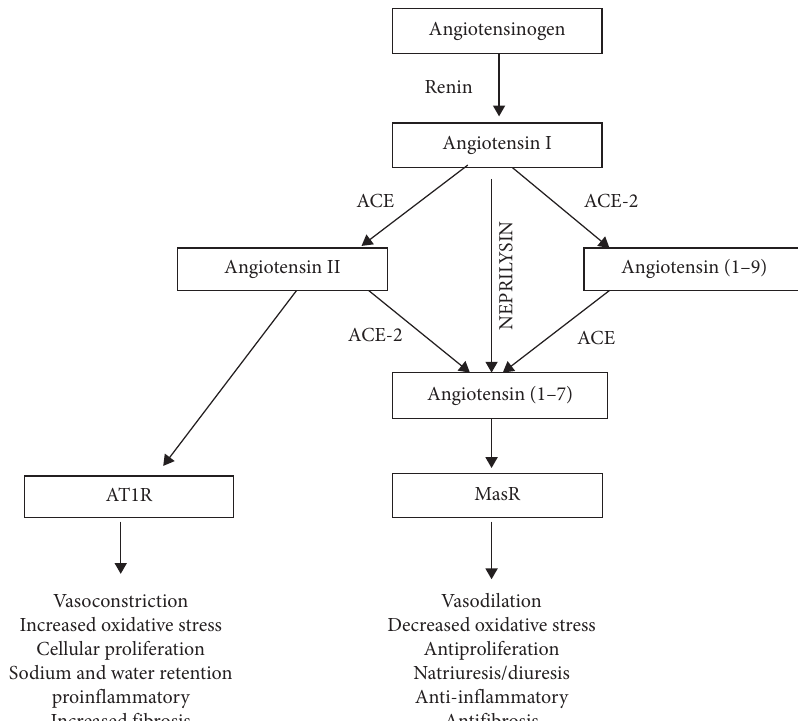
Figure 1: Roles of ACE (angiotensin-converting enzyme) and ACE-2 (angiotensin-converting enzyme-2) in the renin-angiotensin system. Renin cleaves angiotensinogen produced by the liver to angiotensin I which is further cleaved to angiotensin II by ACE enzyme. The primary function of the ACE-2 enzyme is to cleave angiotensin II to angiotensin (1–7) and angiotensin I to inactive angiotensin (1–9). The angiotensin II exerts its negative effects of vasoconstriction, proinflammation, and profibrosis through its interaction with the AT1R (angiotensin II type 1 receptor). In contrast, the angiotensin (1–7) exerts its beneficial effects of vasodilation, anti-inflammation, and antifibrosis through its interaction with MasR (Mas receptor).